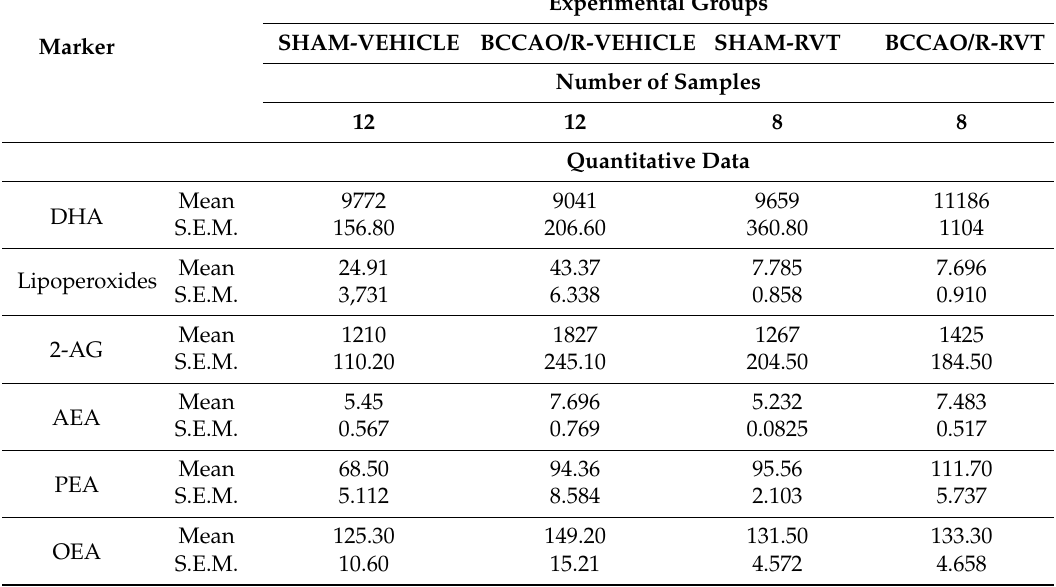
Frontal cortex. docosahexaenoic acid (DHA), lipoperoxides, endocannabinoids 2-arachidonoylglycerol (2-AG) and arachidonoylethanolamide (AEA), and endocannabinoid congeners palmitoylethanolamide (PEA) and oleoylethanolamide (OEA) obtained after resveratrol (RVT) pre-treatment by means of High Performance Liquid Chromatography-Mass Spectrometry